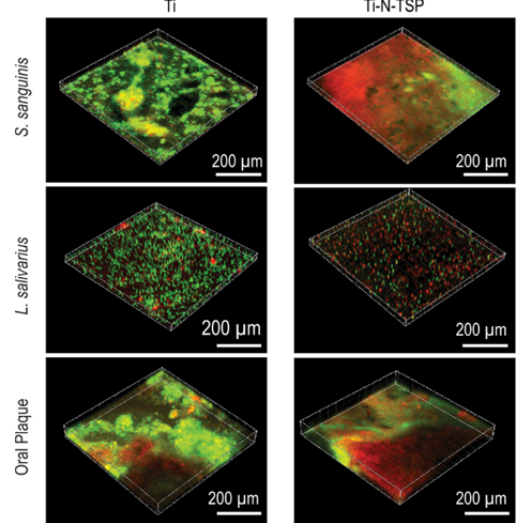
Figure 5. Live (green)/dead (red) staining of Streptococcus sanguinis , Lactobacillus salivarius and complete oral plaque incubated at 37 °C after 4 weeks of incubation onto titanium (Ti) and TESPSA modified (Ti–N–TSP) samples.